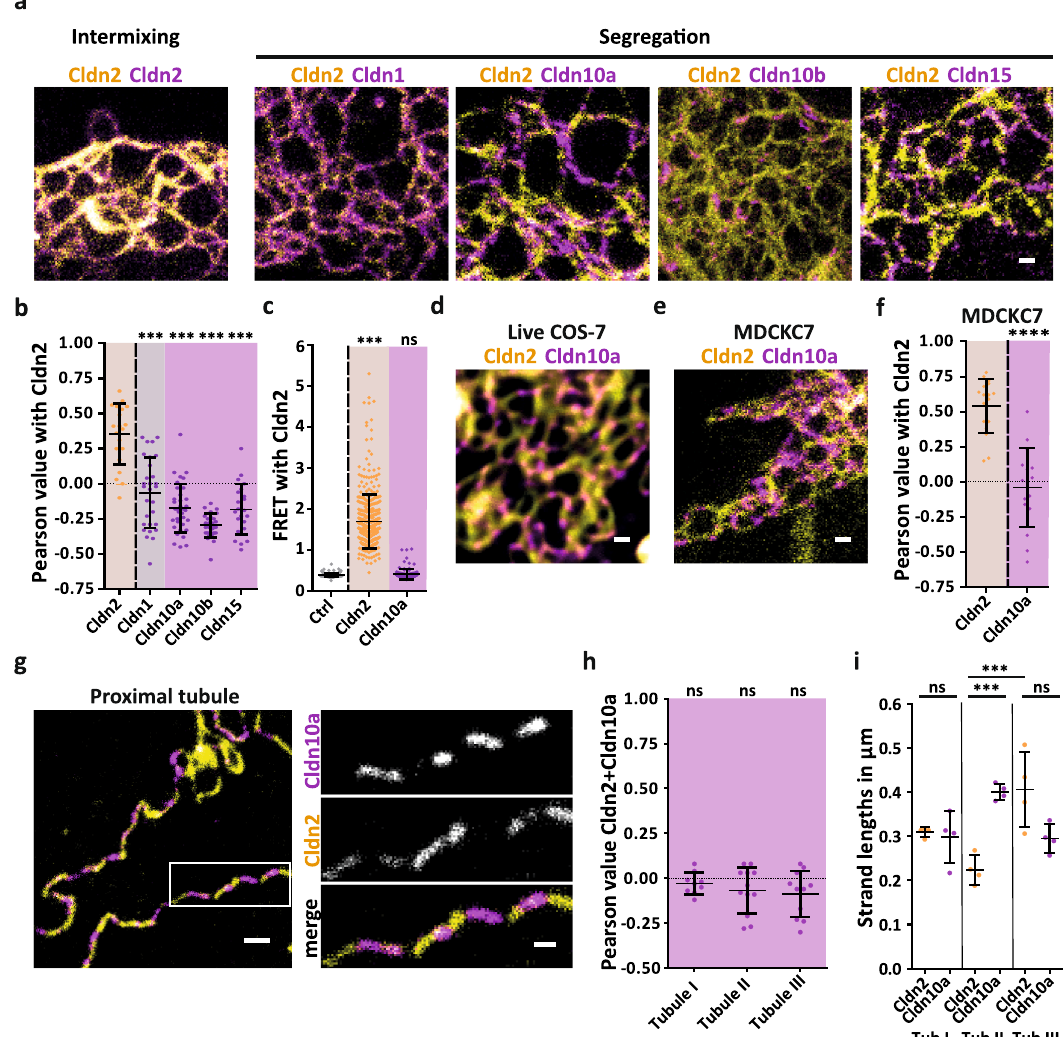
Fig. 4 | Channel-forming claudins form segregated meshworks in non- polarized cells, epithelial cells and the murine proximal tubule. a Representative STED image of TJ-like meshwork formed by SNAP-Cldn2 (yel- low; BG-Atto590) co-expressed with YFP-tagged Cldn2, Cldn1, Cldn10a, Cldn10b, and Cldn15 (all magenta; α -GFP-NB-Atto647N) in COS-7 cells. b Pearson correlation analysis of Cldn2 co-expressed with Cldn2 (yellow), Cldn1 (gray) and Cldn10a, Cldn10b, Cldn15 (magenta). Data represent the mean±SD. Every n represents the Pearson of one TJ-like meshwork. n (Cldn2+Cldn2)=21; n (Cldn2+Cldn1)=29; n (Cldn2+Cldn10a)=35; n (Cldn2+Cldn10b)=28; n (Cldn2+Cldn15)=22; from 3 to 5 independent experiments; one-way ANOVA with Dunnett ’ s multiple comparison test; *** P ≤ 0.001, ns (not signi fi cant). c SpectralFRETanalysisofTrq2-Cldn2(blank;negativecontrol)orco-expressed with YFP-tagged Cldn2 (yellow; positive control) and Cldn10a (magenta) in HEK cells. Data represent the mean±SD. Every n represents one cell – cell contact. n (negative control)=126, from one experiment; n (Cldn2+Cldn2)=405; n (Cldn2+Cldn10a)=115; from 4 to 10 independent experiments; one-way ANOVA with Dunnett ’ s multiple comparison test; *** P ≤ 0.001, ns (not sig- ni fi cant). d Representative STED image of segregating SNAP-Cldn2 (yellow; BG- JF646) and Halo-Cldn10a (magenta; CA-Atto590) in living COS-7 cells. Image noise was removed for visualization using noise2Void 70 . e Representative STED image of segregation of SNAP-Cldn2 (yellow; BG-Atto590) and YFP-Cldn10a